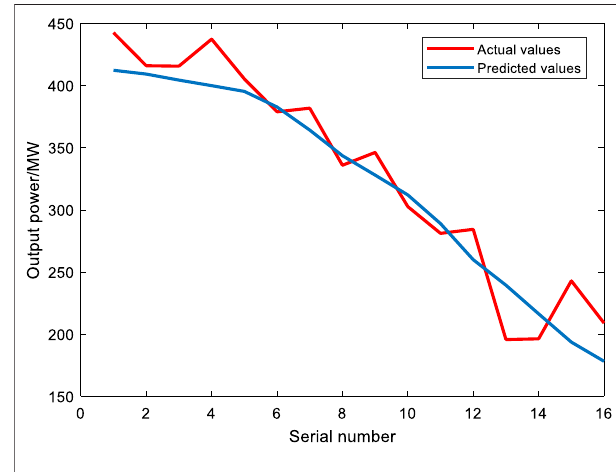
FIGURE 10 | Sampling points with the highest prediction accuracy for June 21, the day with the highest daily average prediction